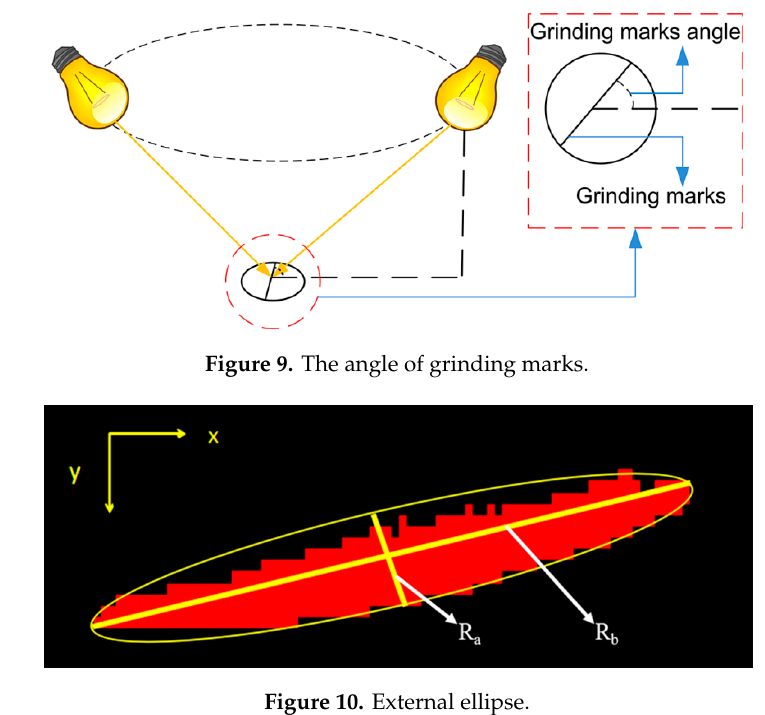
Figure 11. The extraction process of grinding marks. ( a )